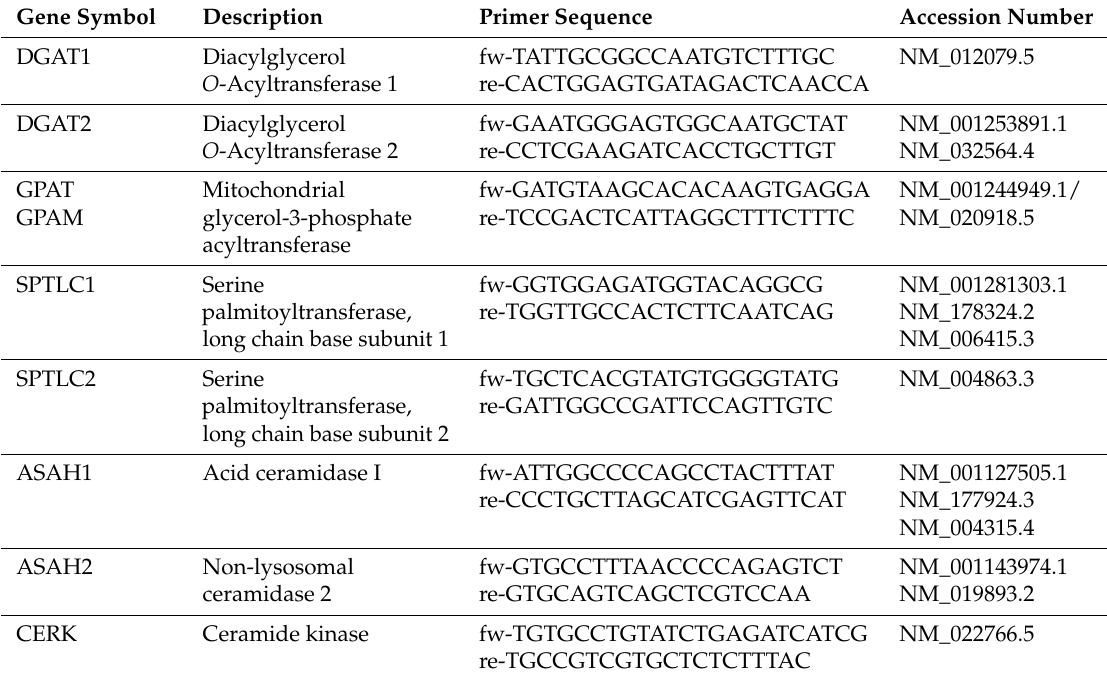
Table 1. Details of mRNA primer